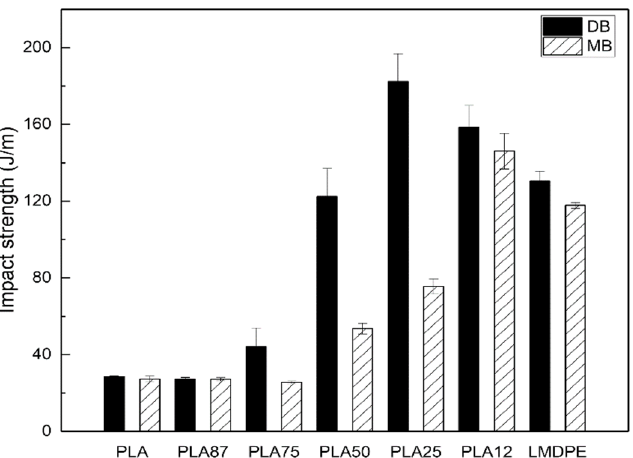
Figure 9. Impact strength of the rotomolded parts.